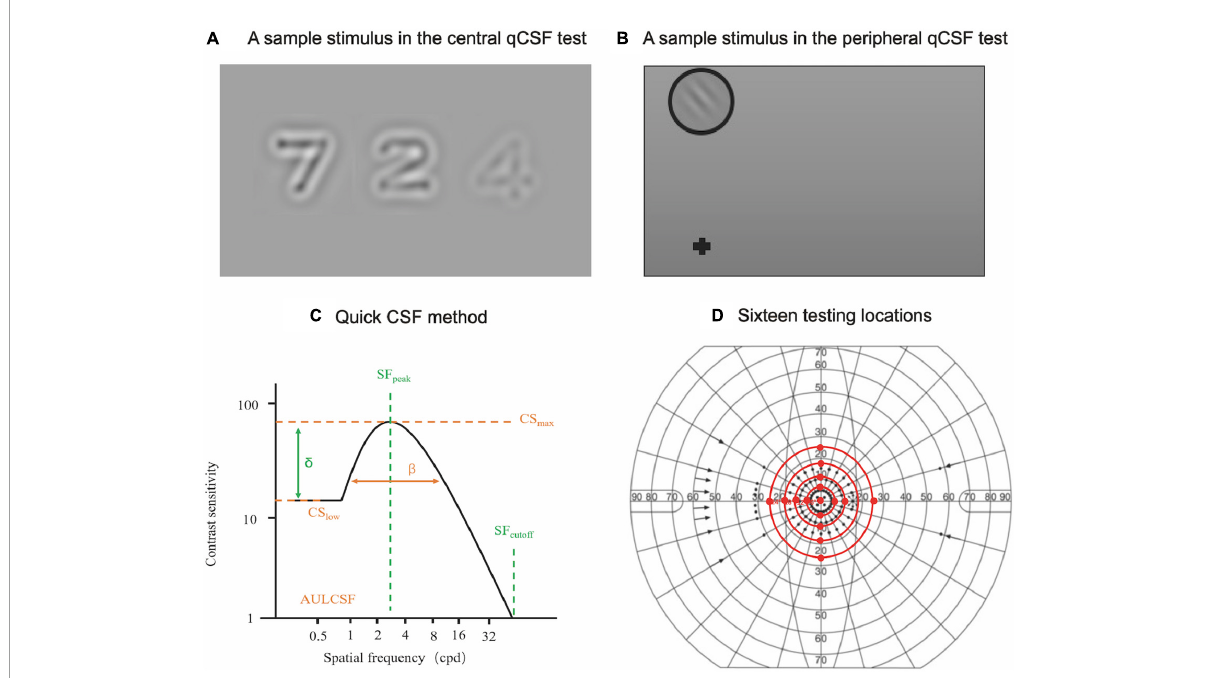
FIGURE1 Central and peripheral qCSF measurements. (A) A sample stimulus depicting digits presented on the LCD monitor during the central qCSF test. (B) A sample stimulus presented on the LCD monitor for the peripheral qCSF test. (C) The truncated log-parabola CSF model used in the qCSF paradigm, with four parameters: peak sensitivity (CSmax), peak SF (SFpeak), bandwidth ( β ), and low-SF truncation ( δ ) (Barbot et al., 2021). (D) Sixteen testing locations (central and peripheral testing locations, excluding the physiological scotoma) in the peripheral CSF